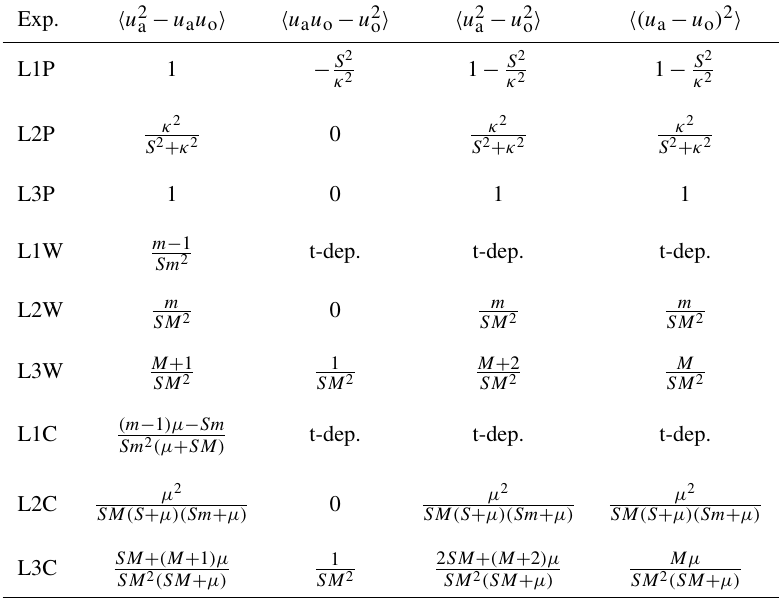
Table 2. Differences of second-order-moments of the velocity (normalised by 2 (κ 2 + (Sm) 2 ) for L1P and L2P, by 2 (κ 2 + (SM) 2 ) for L3P, by R for LxW and by R/µ 2 for LxC ). Note that for µ (cid:29) SM , LxC converges to LxW .